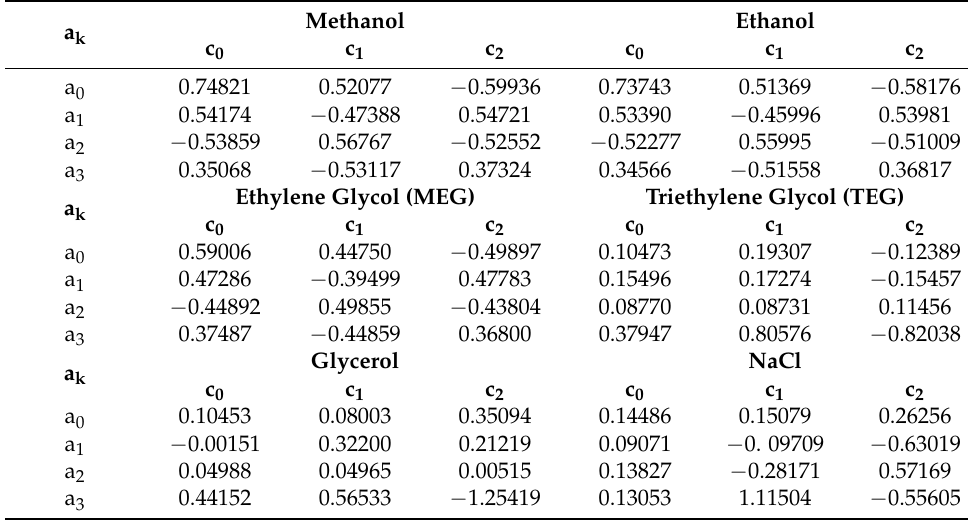
Table 1. Model and parameters for water activity coefficients for Equation (1). a